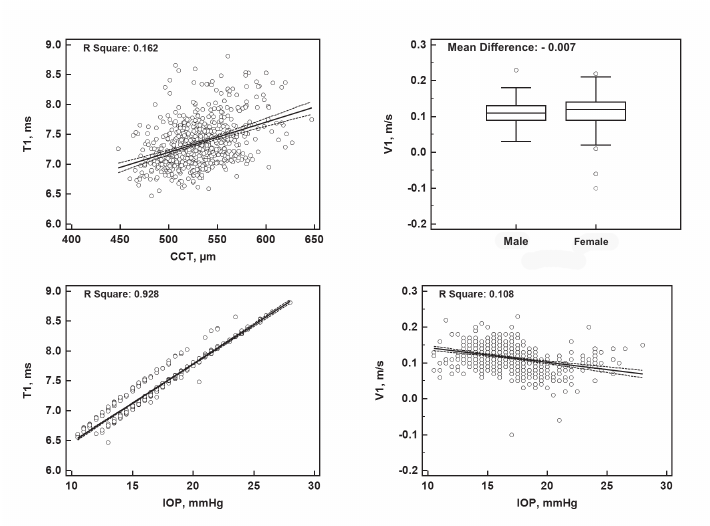
Figure 1. Significant determinants of the selected Corvis ST parameters at the first applanation moment. CCT, central corneal thickness; IOP, intraocular pressure.